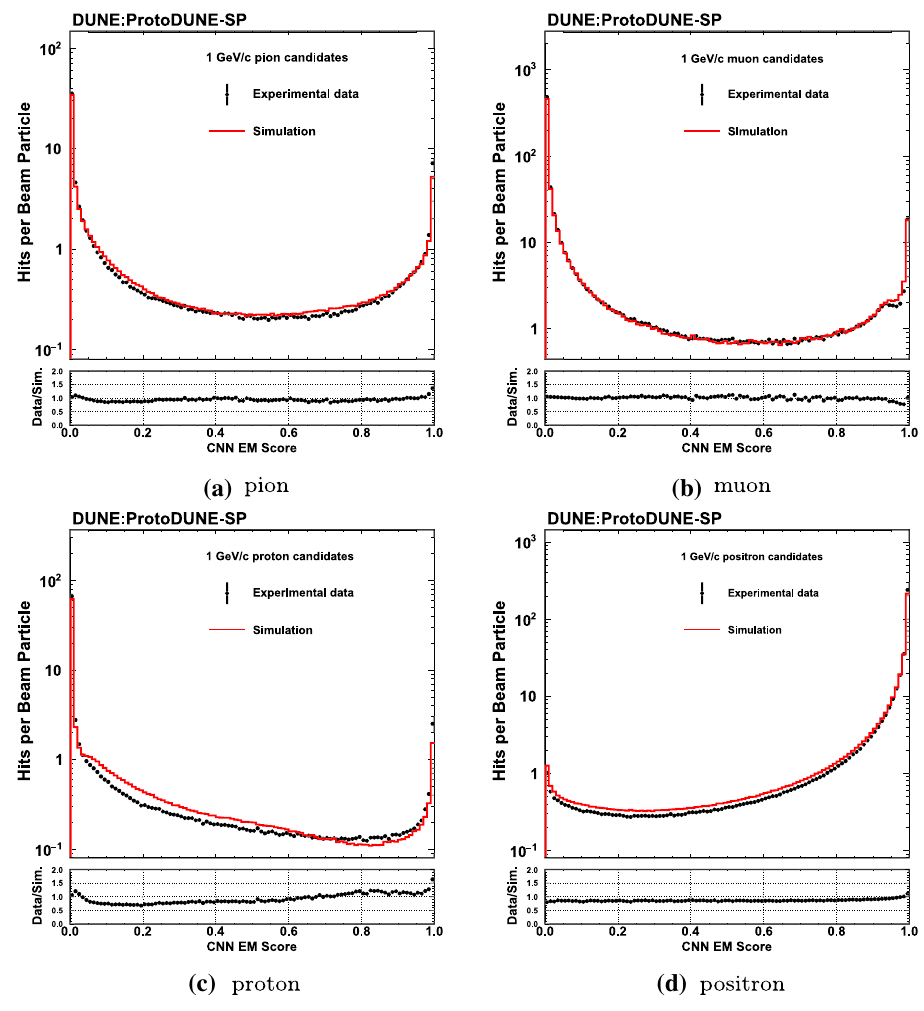
scores for different particle species in the ProtoDUNE-SP beam. The error bars on the experimental data are